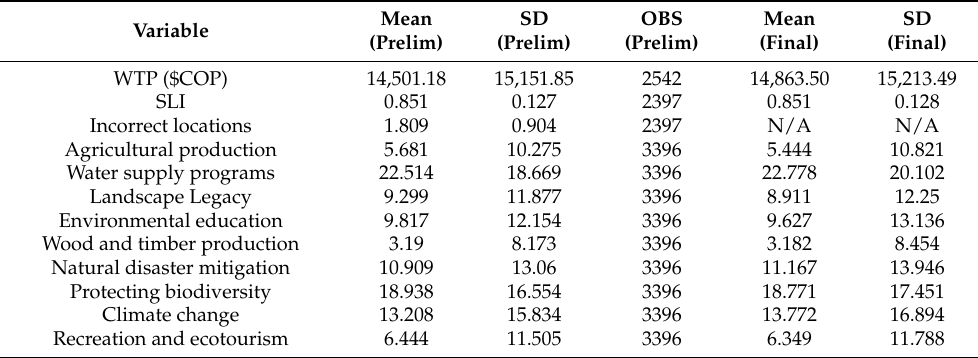
Table 3. Descriptive statistics for the Prelim and Final datasets used in the valuation analysis for Bogot á , Colombia. SD, standard deviation; OBS, observations; WTP, willingness to pay; SLI; spatial literacy index. The number of observations for the cleaned dataset are 2359 for each variable